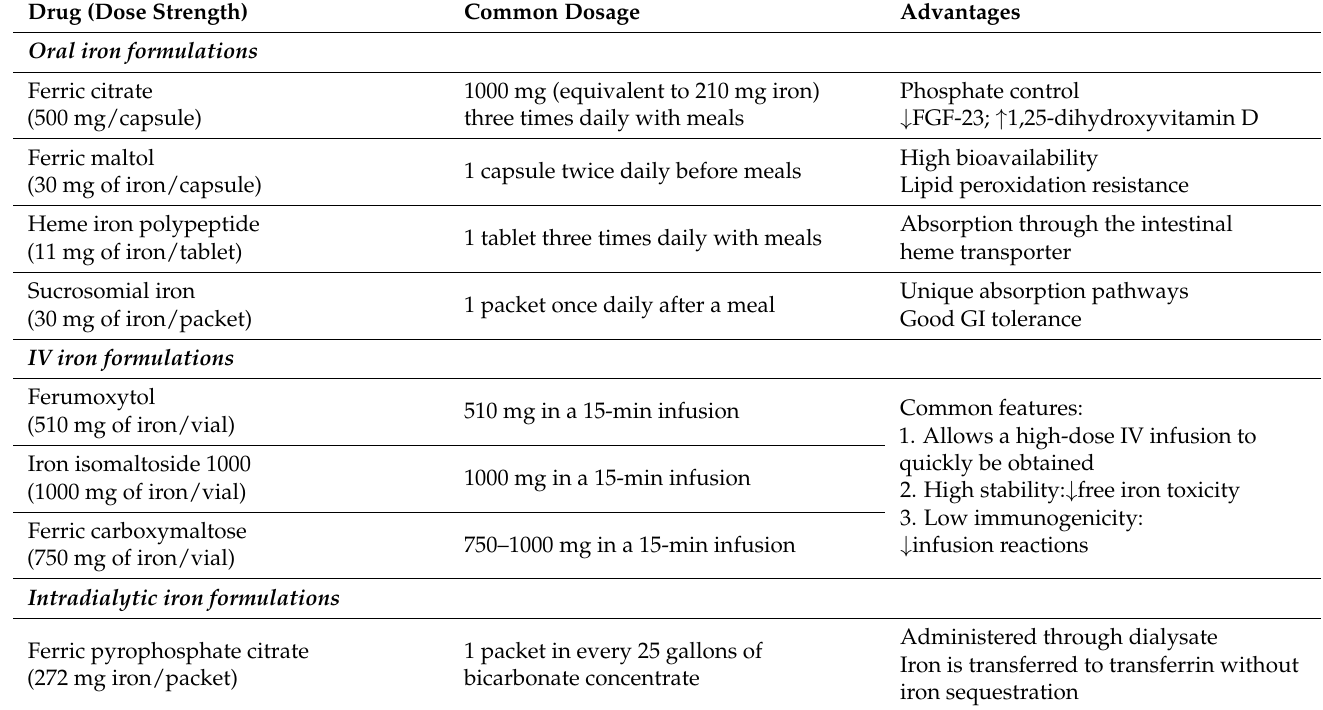
Table 1. Summary of modern iron therapies in patients with chronic kidney